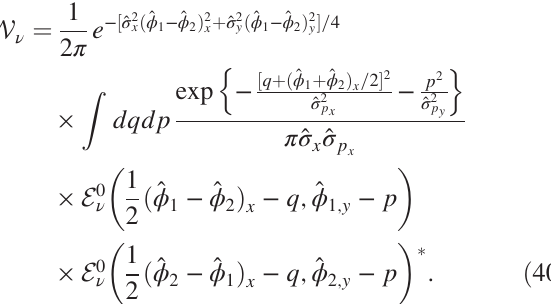
× a inthetransverseplane x y ˆ ε ∼ 10 − 3 x y Þ